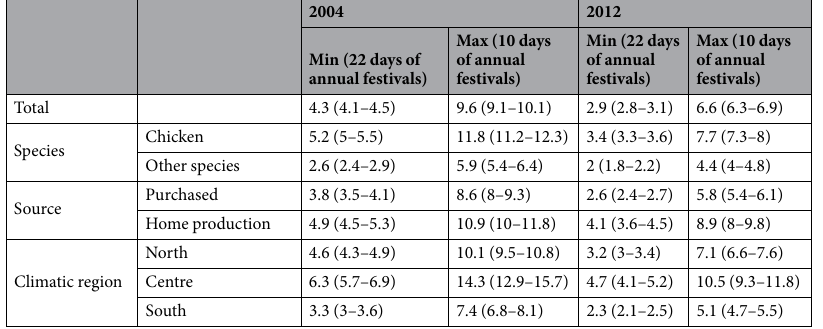
Table 1. Ratio between average daily poultry meat consumption during the Lunar New Year Period and outside that period in Vietnam (along with their 95% confidence intervals) by species and source (from Vietnam Households Livelihood Standard Survey in 2004 and 2012).